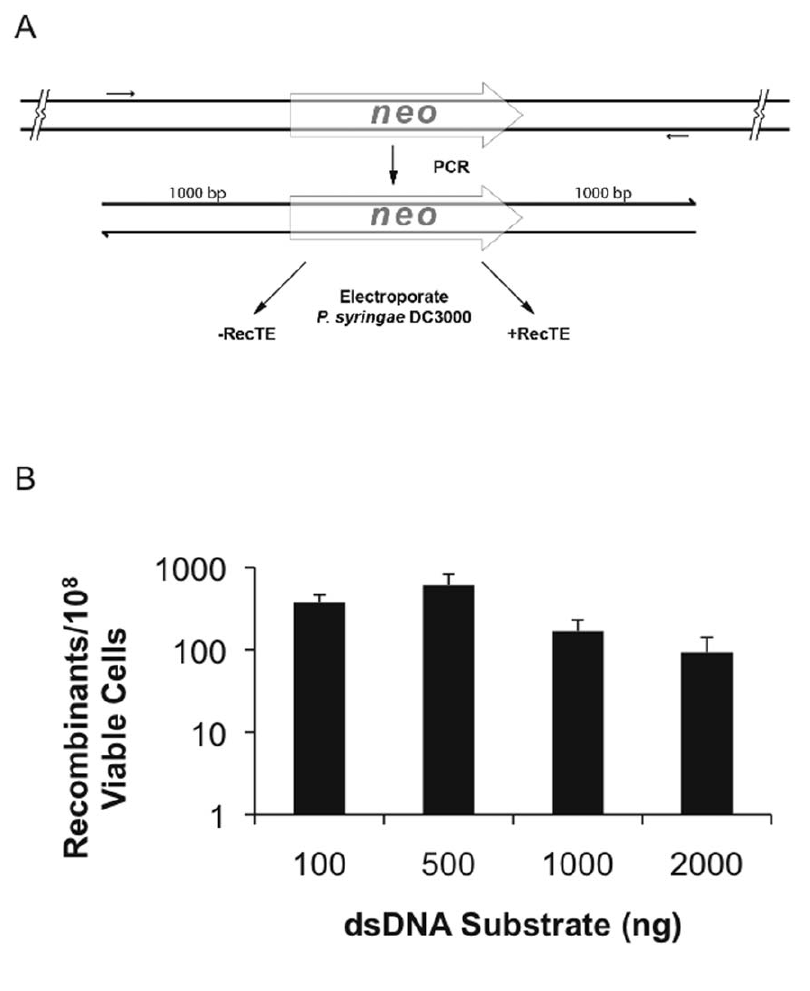
Figure 1. The amount of dsDNA substrate influences RecTE Psy recombination frequency. The amount of PCR product added for electroporations was varied in order to determine the effect of substrate concentration on recombination. (A) Recombineering substrates were generated using PCR. The PCR product had 1 kb flanks identical to target location (the PSPTO_1203 locus) at each end of the neo gene encoding kanamycin resistance. This substrate deletes 500 bp of the 543 bp PSPTO_1203 gene and inserts the 1.3 kb neo gene in its place. (B) Maximum recombination frequency was observed when 500 ng of PCR product was added to the electroporations with RecTE Psy present. The results are the average of four independent replicates, error bars indicate standard deviation. No kanamycin resistant colonies were observed in the absence of the RecTE Psy expression vector (data not shown).